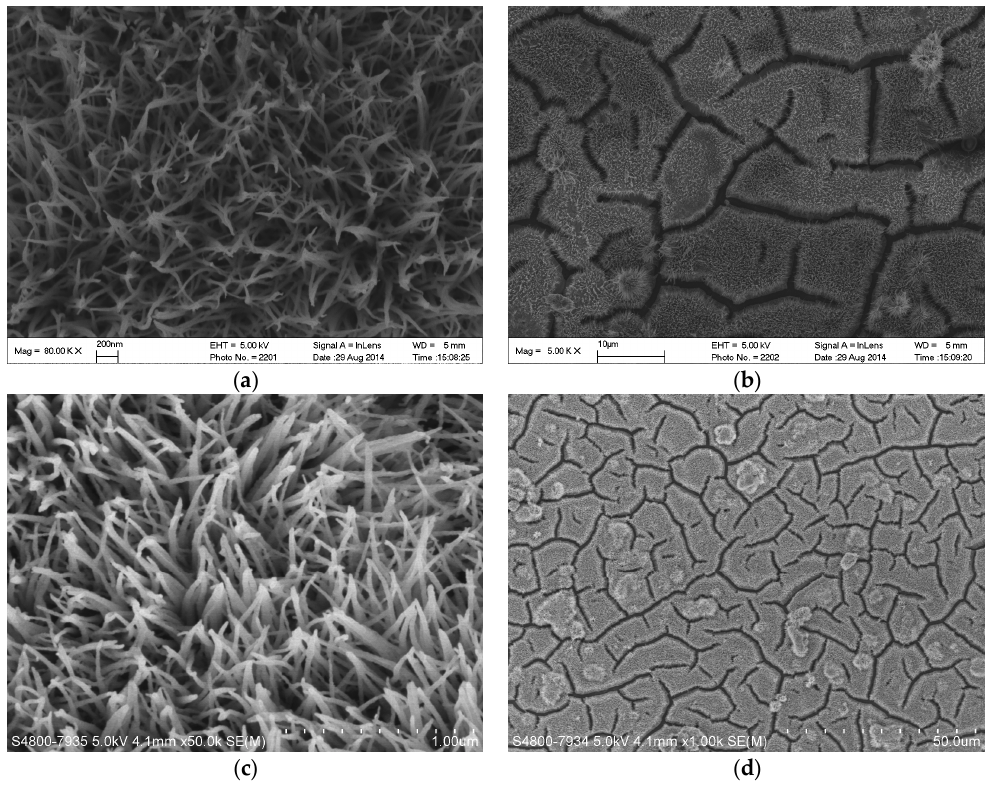
Figure 2. Scanning electron microscope (SEM) images of TiO 2 nanowire arrays: the sample of rectangular plate (20 mm × 30 mm) with 0.2 mm thickness under the magnification of 80.0 k ( a ) and under the magnification of 5.0 k ( b ); the sample of circular disc ( φ 200 mm diameter) with 0.8 mm thickness under the magnification of 50.0 k ( c ) and under the magnification of 5.0 k ( d ).